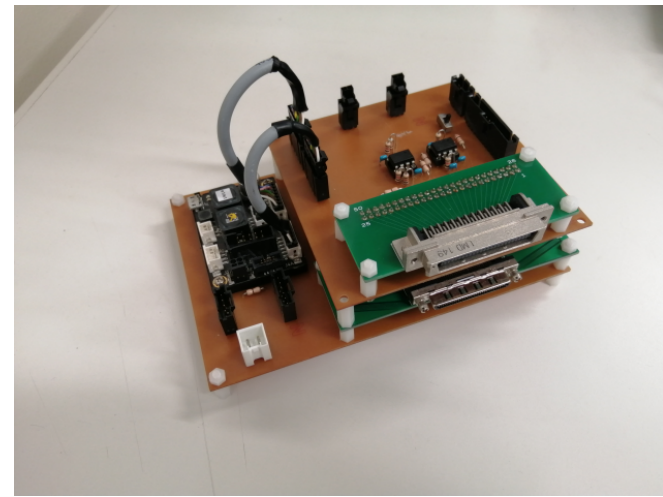
Figure 2. Robot arm used in this research (Electric